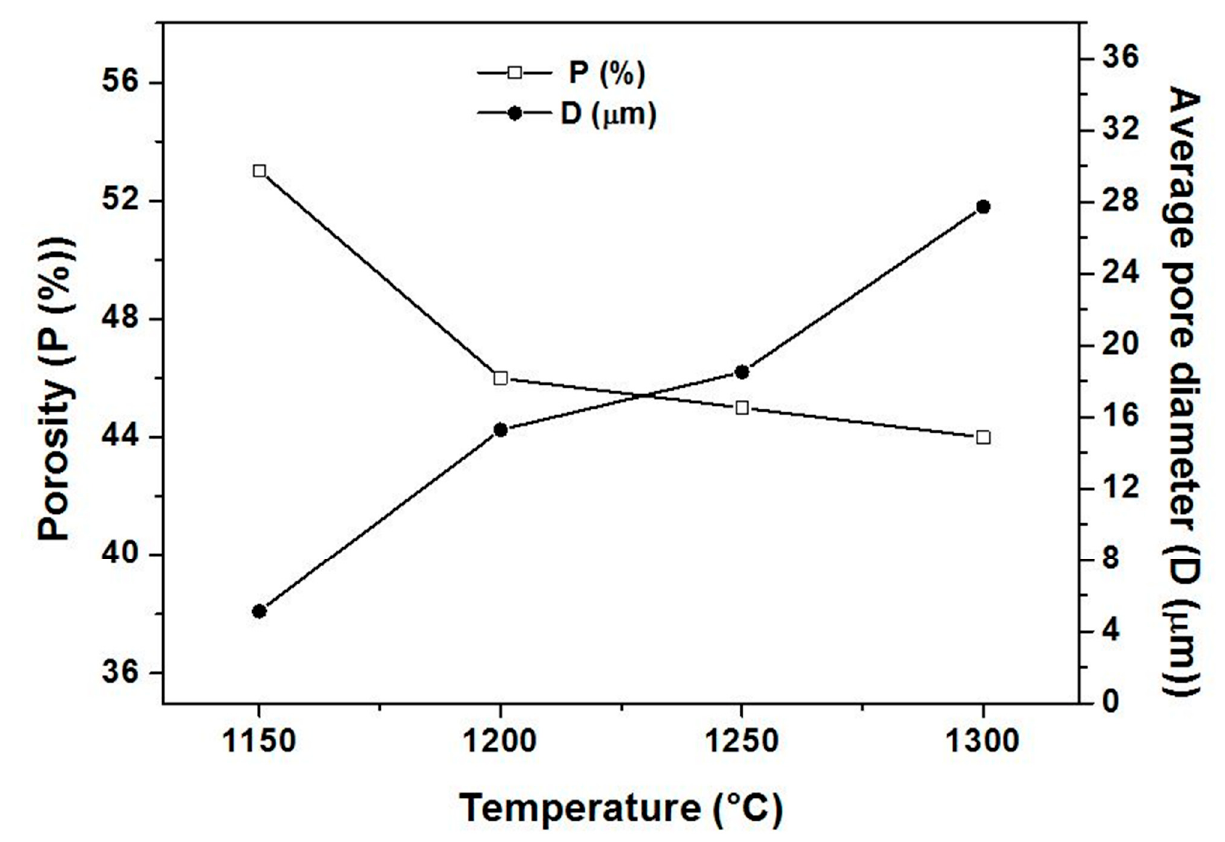
Figure 5. Variation of porosity ratio (P) and average pore diameter (D) as a function of the sintering temperature.